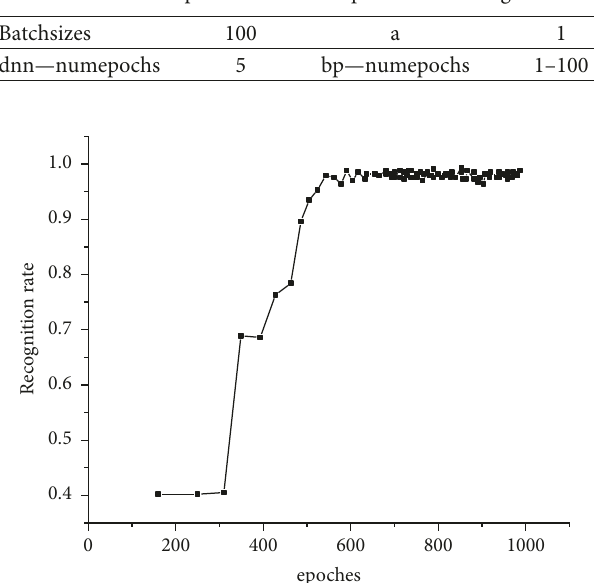
Table 2: Deep neural network parameter settings.